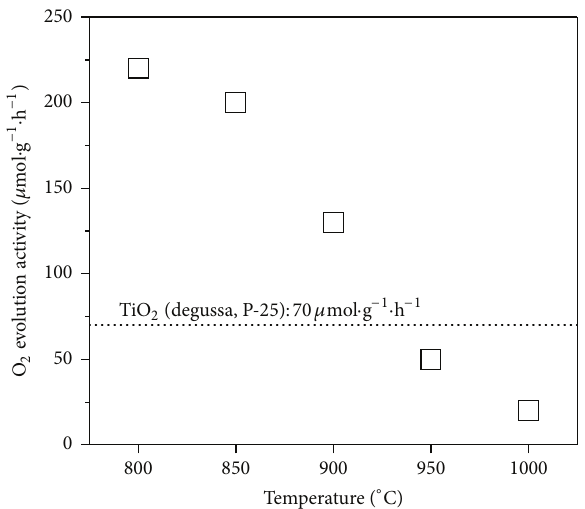
Figure 6: O 2 evolution rate of the 𝛽 -TaON powders as a function of the nitridation temperature. 0.1g 𝛽 -TaON dispersed in an aqueous AgNO 3 solution was irradiated with a 150 W halogen